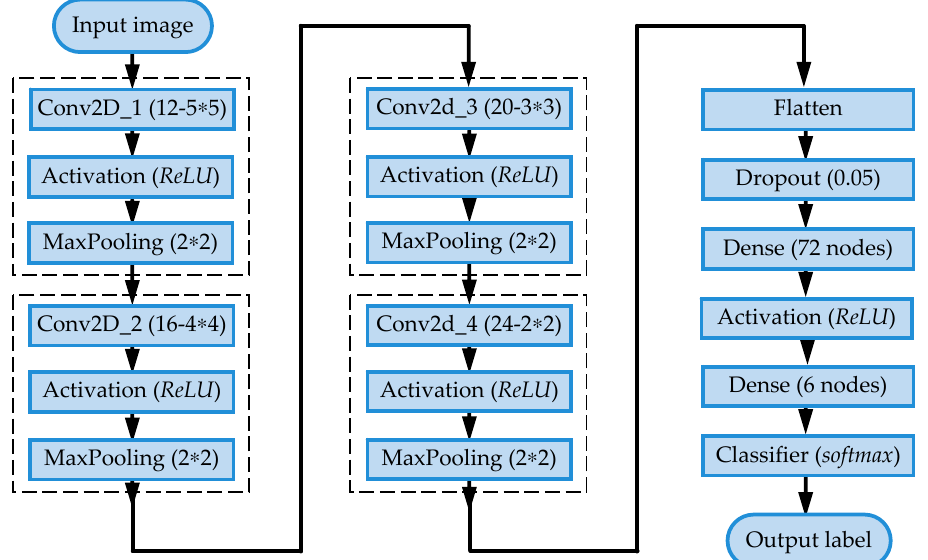
Figure 12. The architecture of the CNN model used in this paper, where “Conv2d_1 (12-5*5)” refers to the first convocation layer consists of 12 filters with a size of 5*5, “MaxPooling (2*2)” refers to max pooling layer with a pooling size of 2*2.